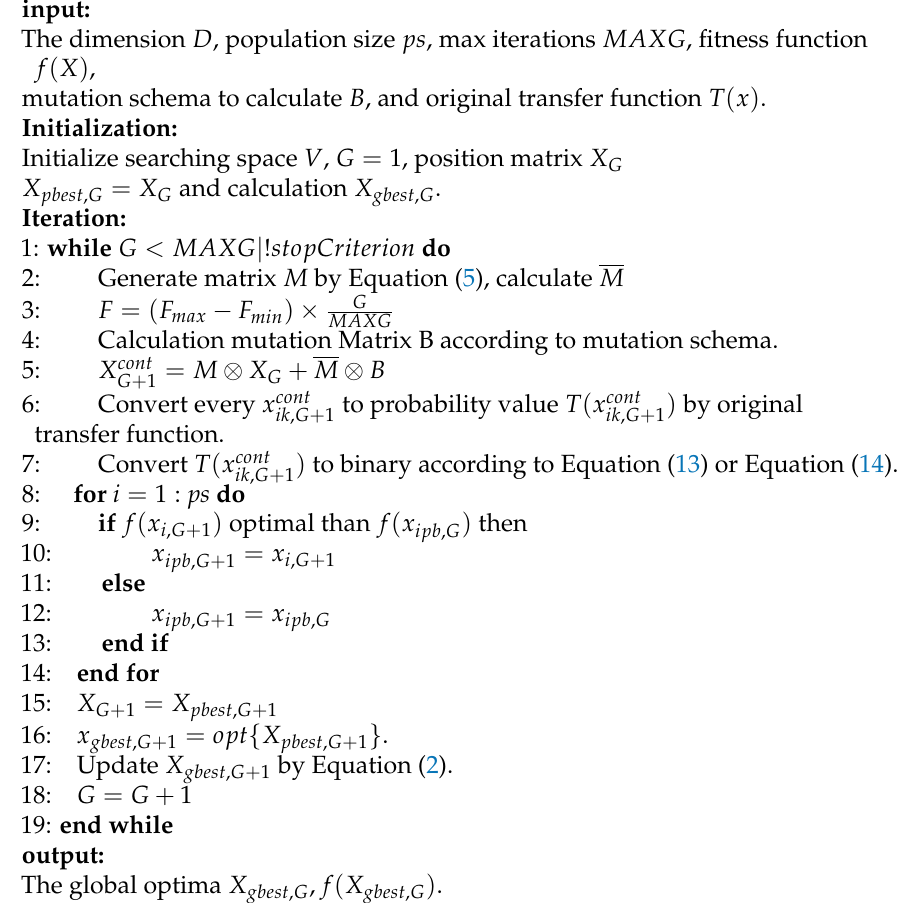
Algorithm 2: Pseudo code of binary QUATRE algorithm-Approach 1(BQUA-